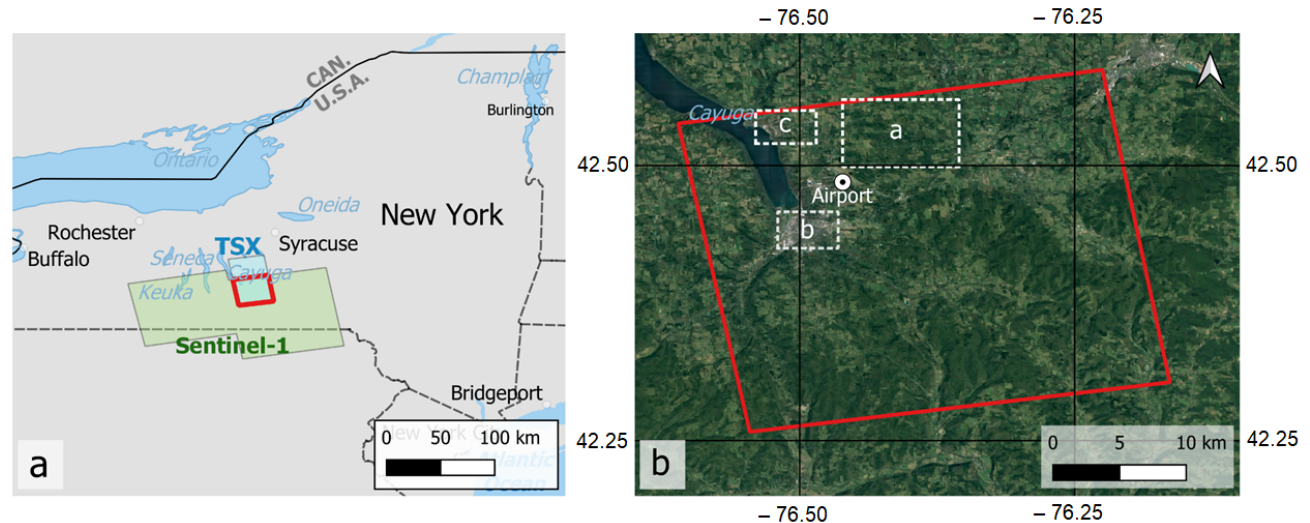
Figure 1. ( a ) Overview map of the study area. The S1 and TSX frames are shown in green and blue, respectively. Red indicates the study area covered by both datasets. ( b ) Target regions within the study area (red (same as in (a)) include a rural, heavily vegetated region (a), the city of Ithaca (b), the Cayuga Salt Mine (c), and the Ithaca airport. Basemap imagery available through Google: imagery @2023 TerraMetrics; map data